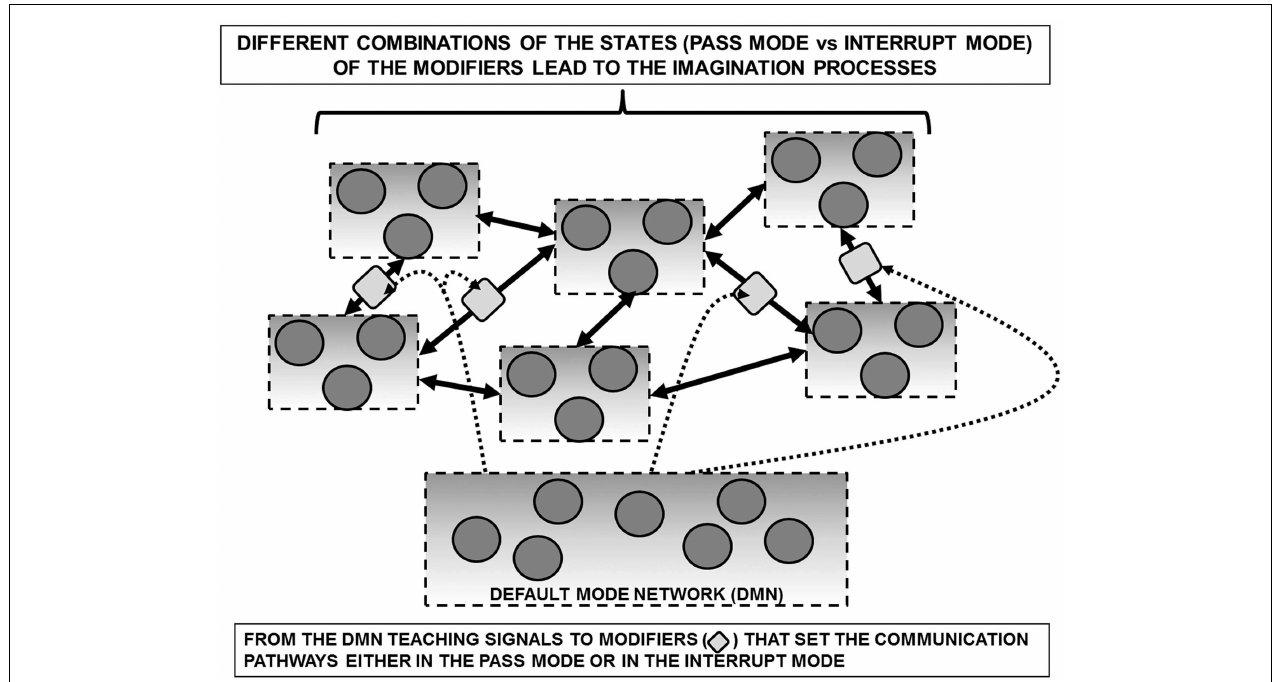
dependent from sensory inputs. In support of such a hypothesis is the observation that the DMN shows high metabolic activity and blood flow at rest but is commonly deactivated during a variety of externally directed tasks. For further details, see